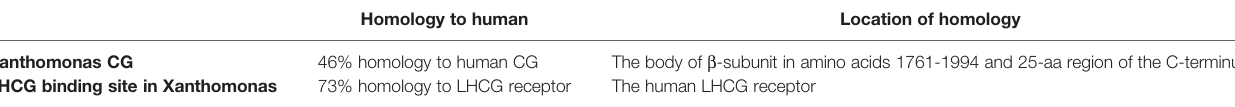
TABLE 2 | Homology between bacterial CG and human CG.